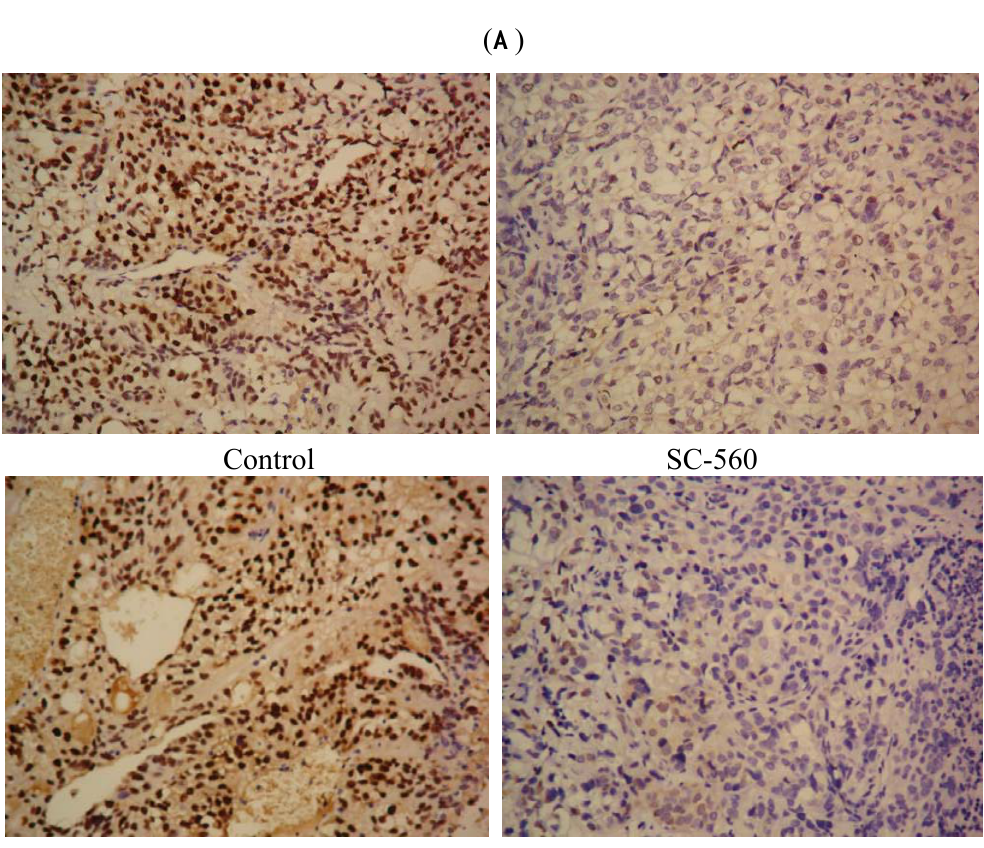
Figure 2. Effects of cyclooxygenase (COX) inhibitors and taxol on cyclin D1 activation in SKOV-3 xenograft tumors. ( A ) Representative pictures of cyclin D1